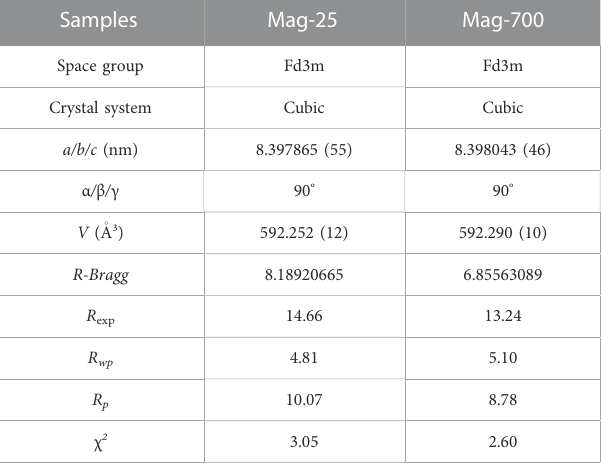
TABLE 5 Magnetite re fi nement parameters were obtained from the Rietveld re fi nement using X-ray powder diffraction data at room temperature. Samples Mag-25 Mag-700